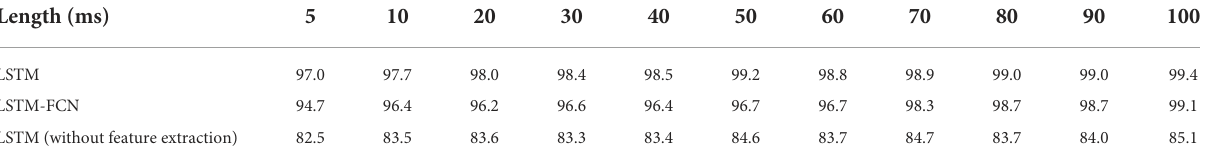
TABLE 5 LSTM and LSTM-FCN-based PHRC state recognition (Group 3 features; %). Length